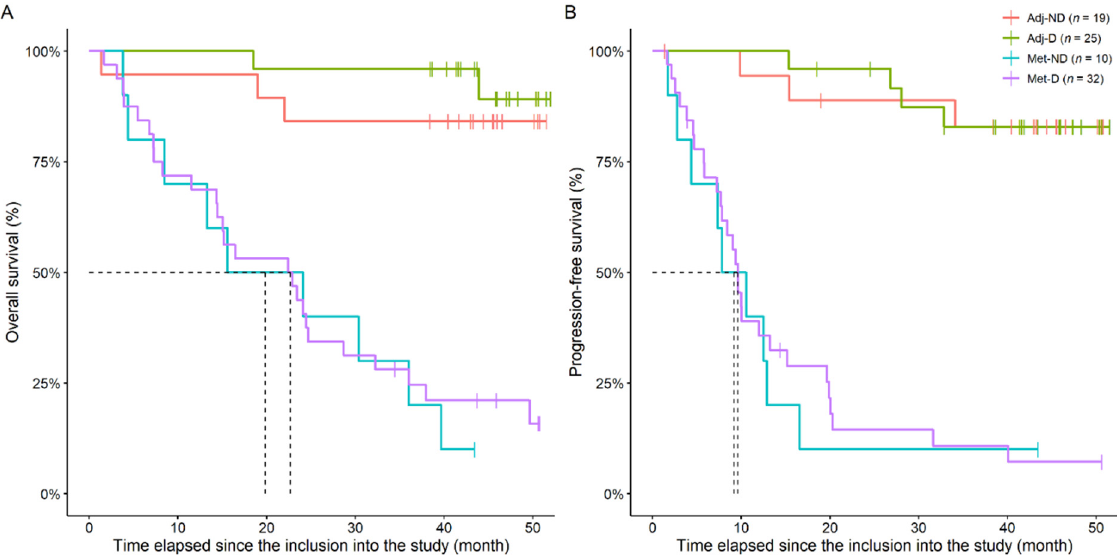
Figure 7. Naïve overall ( A ) and progression-free ( B ) Kaplan–Meier survival curves of the study cohorts. Adj-ND: patients without metastasis and no vitamin D 3 supplementation; Adj-D: patients without metastasis with vitamin D 3 supplementation; Met-ND: patients with metastasis and no vitamin D 3 supplementation; Met-D: patients with metastasis with vitamin D 3 supplementation. Dashed line represents median survival times.